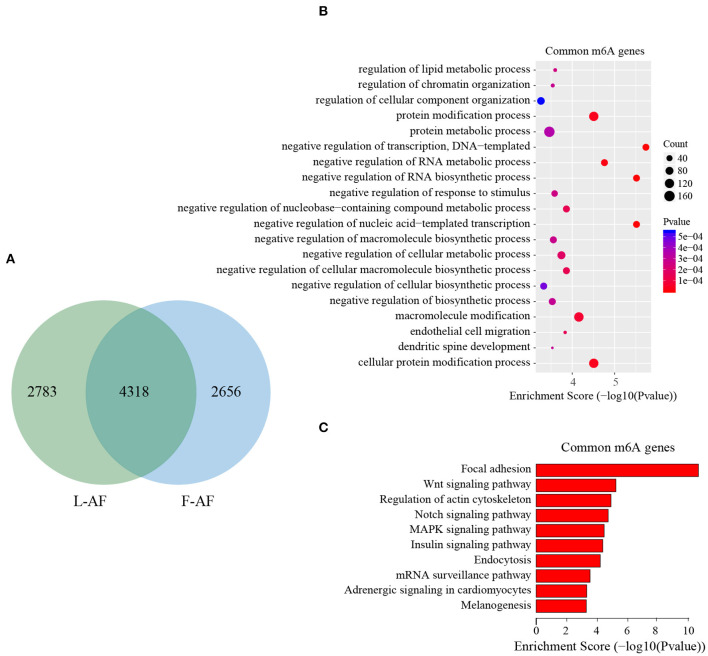
GO biological process and KEGG pathway analyses of common m6A genes in broiler chickens. (A) Venn diagram showing overlap of the m6A peaks from L-AF and F-AF samples. (B) GO enrichment analysis of common m6A genes (P < 0.05). (C) Pathway analysis of common m6A genes (P < 0.05).